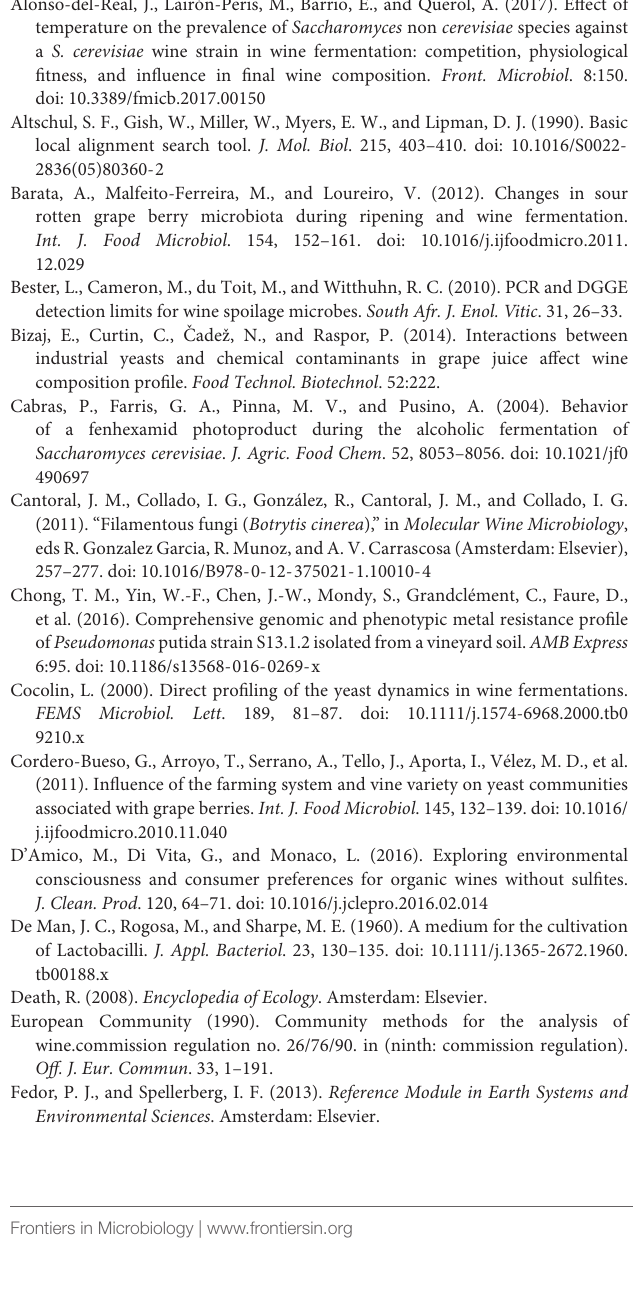
FIGURE S1 | Some of the WLAB1-2 amplicons and species detected by DGGE in control replicates (C1, C2, C3, and C4), in samples form biofungicide treatment (B1, B2, B3, and B4) and in samples from chemical fungicide treatment (Ch1, Ch2, Ch3, and Ch4).